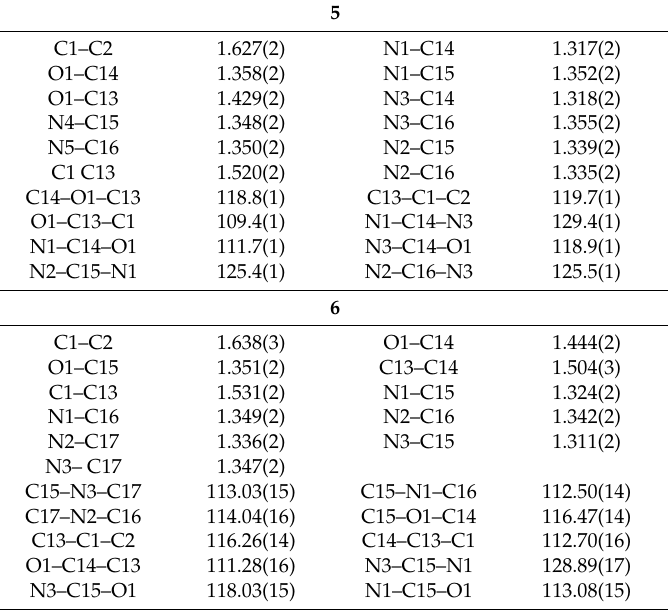
Table 2. Selected bond lengths (Å) and angles ( ◦ ) of 5 and 6 .